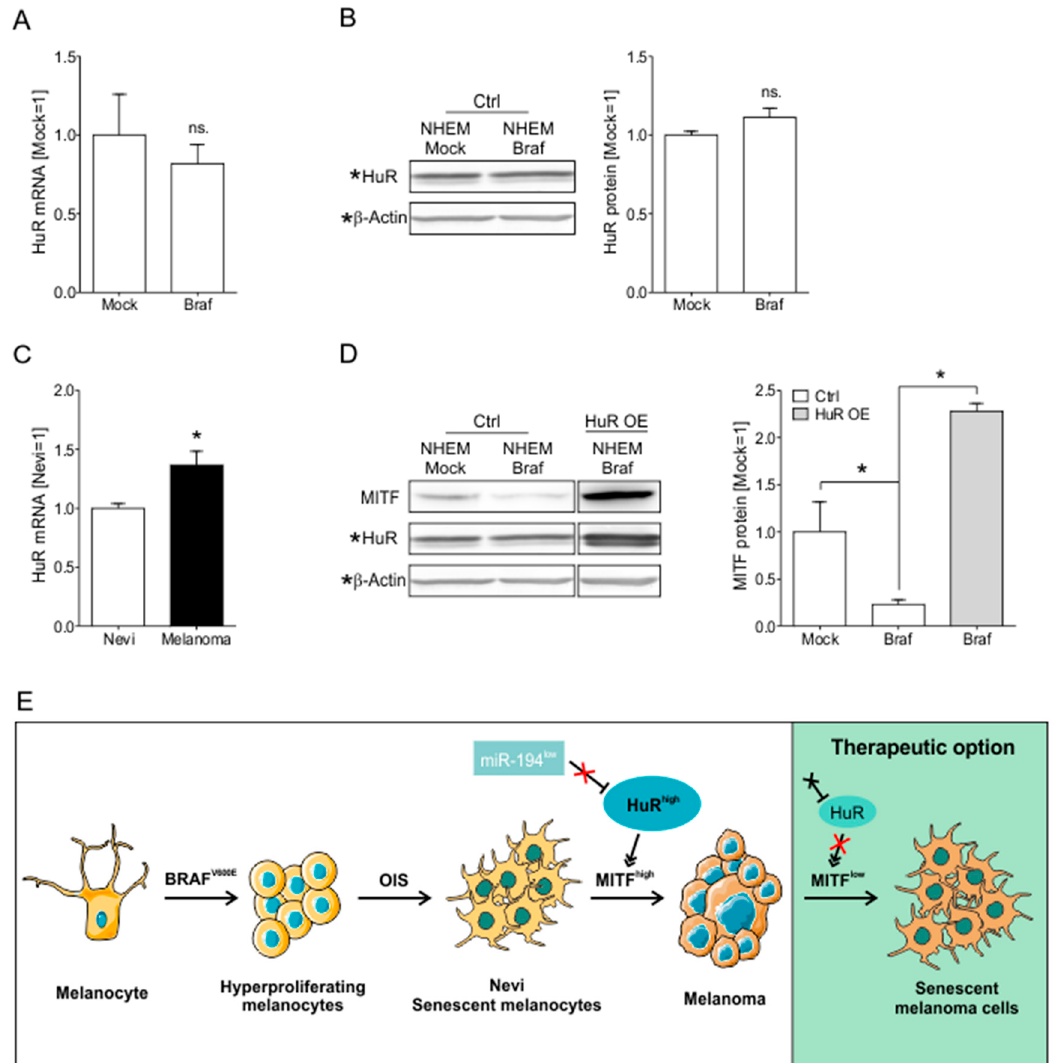
Figure 7. HuR overexpression leads to MITF high phenotype NHEM Braf V600E cells. ( A ) Relative expression of HuR mRNA in NHEM Mock and NHEM Braf V600E cells (Mock = 1). ( B ) Densitometric quantification (left) and exemplary image (right) of Western blot analysis of HuR protein levels in NHEM Mock and NHEM Braf V600E cells (Mock = 1). ( C ) Relative expression of HuR mRNA in matched Nevi and melanoma tissue samples (Nevi = 1). Data derived from the GSE112509 data set. ( D ) Exemplary image of Western blot analysis of MITF protein in NHEM Mock, NHEM Braf V600E , and